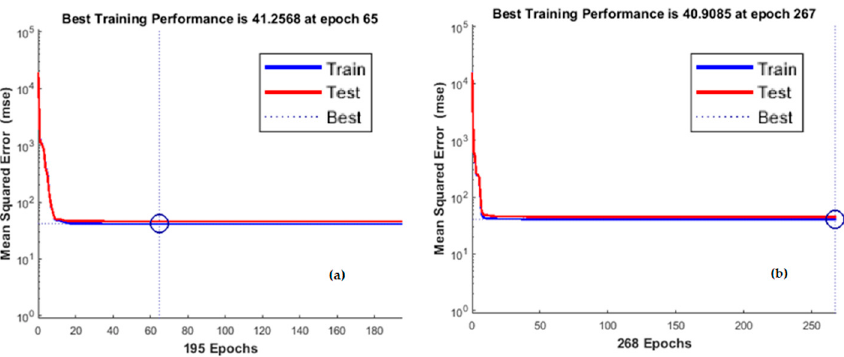
Figure 9. Best training performance ( a ) x coordinates ; ( b ) z coordinates .